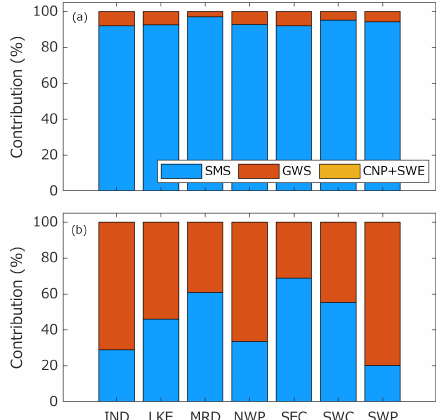
Figure 13. Contributions of different storage components (total soil moisture storage – SMS; groundwater storage – GWS; canopy stor- age – CNP; and snow water equivalent – SWE) to the TWS esti- mates computed from CABLE 0.05 ◦ (a) and GRACE DA 0.05 ◦ (b) in different river basins. The full names of the river basins are given in Fig. 1a. Contributions of CNP + SWE are negligible in both pan-